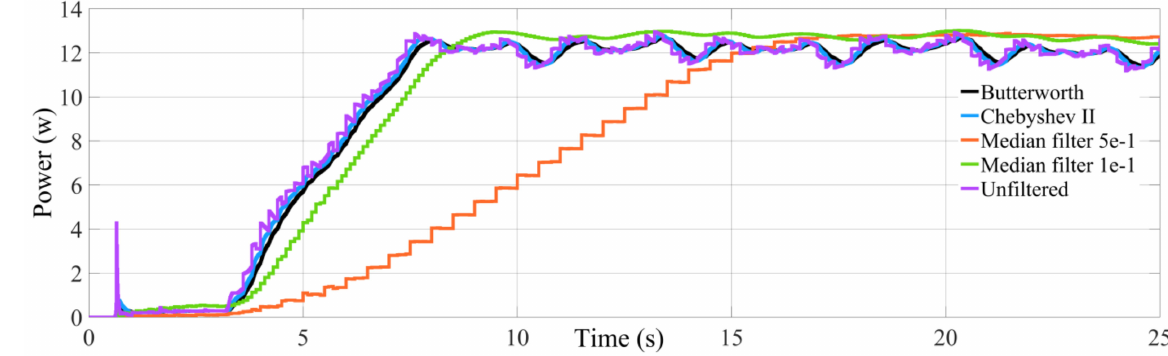
Figure 18. Power output comparison of different filtering methods under rated conditions.